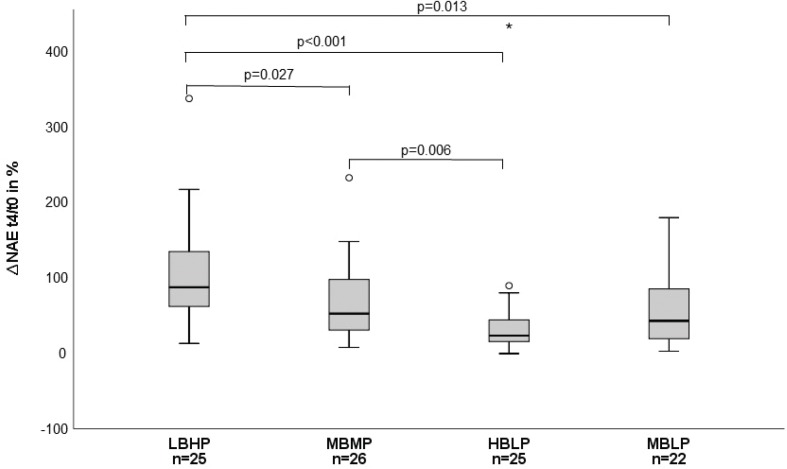
Percentage change of the net acid excretion (NAE) from t0 to t4.